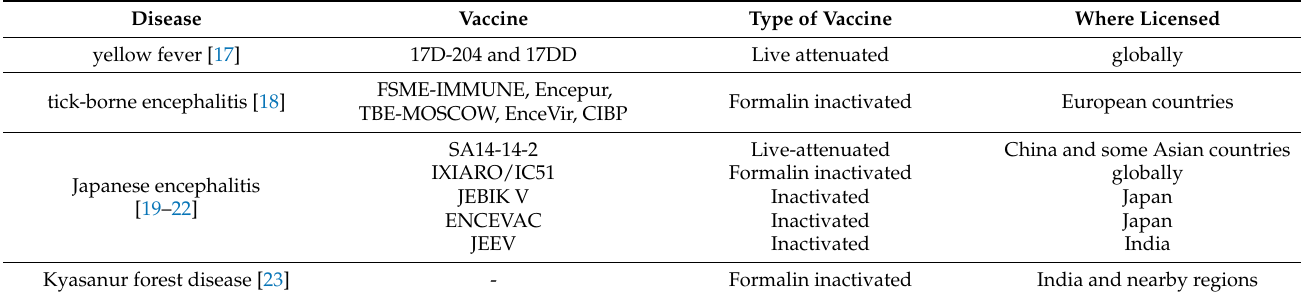
Table 1. Live-attenuated and inactivated-whole flavivirus vaccines that are currently approved for use in humans. Disease Vaccine Type of Vaccine Where